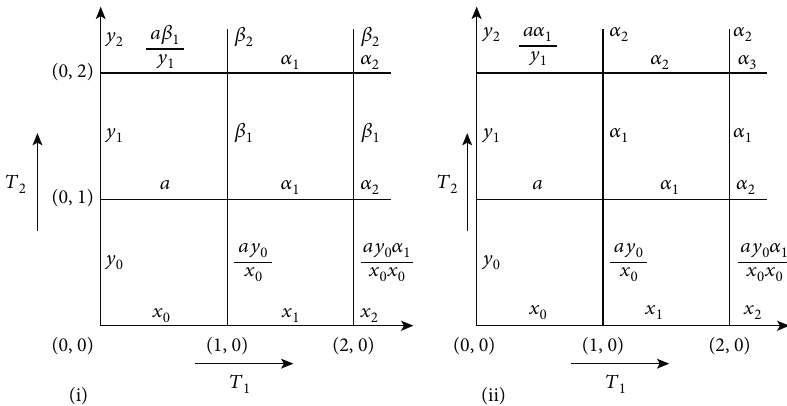
Figure 1: Weight diagram of the 2-variable weighted shift T ∈ T C and weight diagram of the 2-variable weighted shift T ∈ DC ,